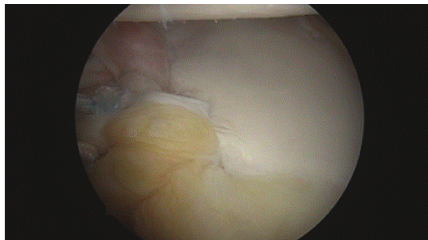
Figure 4: Arthroscopic view of the shoulder demonstrating the remplissage